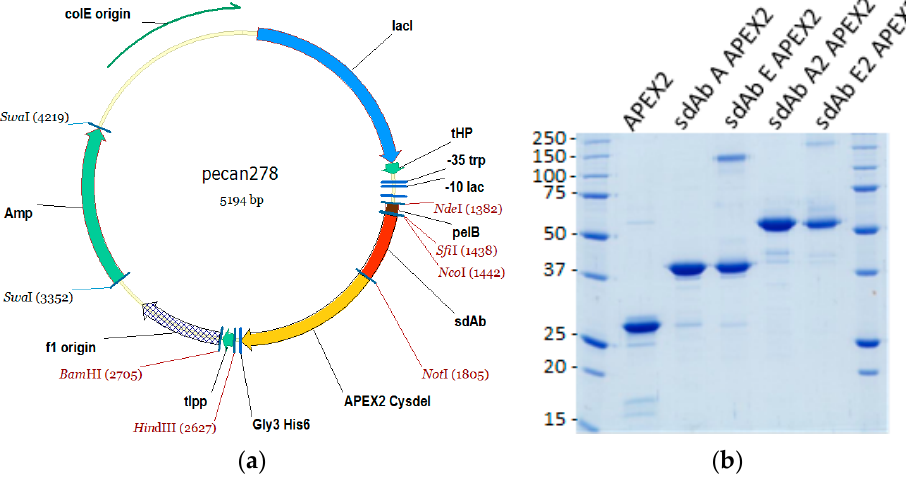
Figure 1. ( a ) Parental sdAb–APEX2 fusion protein expression vector pecan278 enabling switching out of protein-based affinity reagents via Sfi I / Nco I and Not I sites. Amp , ampicillin resistance gene; lacI , lac repressor gene; tHP, terminator; -35 trp and -10 lac, tac promoter; pelB , pectate lyase signal sequence; sdAb, single-domain antibody; APEX2 Cysdel, APEX2 with Cys > Ser; Gly3His6, polyhistidine tag; t lpp , terminator. ( b ) Coomassie Blue stained 12% SDS-PAGE gel of 5 µ g of each of the unfused APEX2 and sdAb–APEX2 fusion protein preparations. Molecular weights of markers are indicated to the left in kDa.